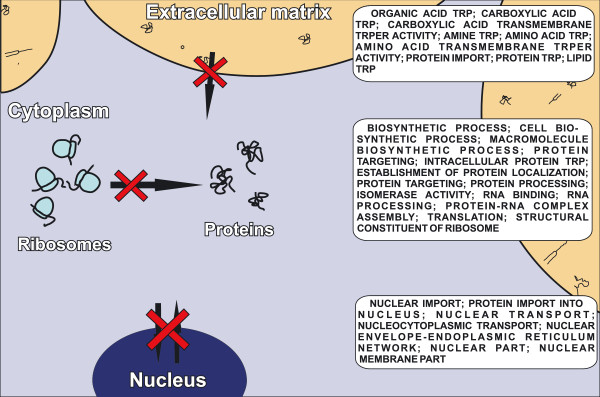
A schematic representation of MDMA’s sites of action in the frontal cortex. This figure summarizes the effects of a single-dose (15 mg/kg, intraperitoneal) 3,4-methylenedioxymethamphetamine (MDMA) administration 3 weeks earlier on the frontal cortex (FC) neurons of Dark Agouti rats. The text boxes mark the selected, grouped processes while red crosses represent the possible sites of action. Almost all of the genes involved in different levels of protein synthesis were downregulated, including nucleocytoplasmic transport, ribosome functioning, protein folding and localization and members in the transport of amino acids and lipids, basic constituents of the cells. These changes strongly suggest a wide-scale impairment of the cellular machinery. However, the formation of new neuronal connections can compensate for these effects (not depicted) on a different scale. See text for further details.